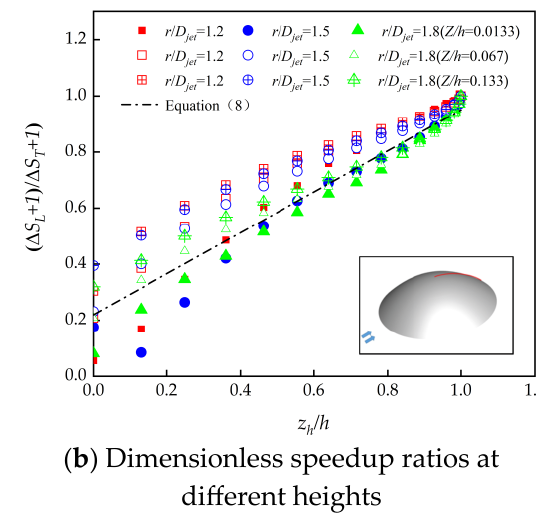
Figure 8. Speedup ratio along the leeward side of the hill model. The speedup ratios at different radial distances along the windward and leeward sides were obtained from Equations (7) and (8), respectively. The hilltop speedup ratio variation with radial distance was determined from these ratios. The speedup ratio distribution of the hill model at different radial positions was then obtained. Figure 9 displays the variation of the hilltop position speedup ratio with radial distance at the near ground position ( Z/h = 0.0133). Before 1.5 D jet , the speedup ratio remained relatively constant with increasing radial distance, but after 1.5 D jet , the speedup ratio decreased more rapidly. The equation for the hilltop speedup ratio variation with radial distance is presented below.